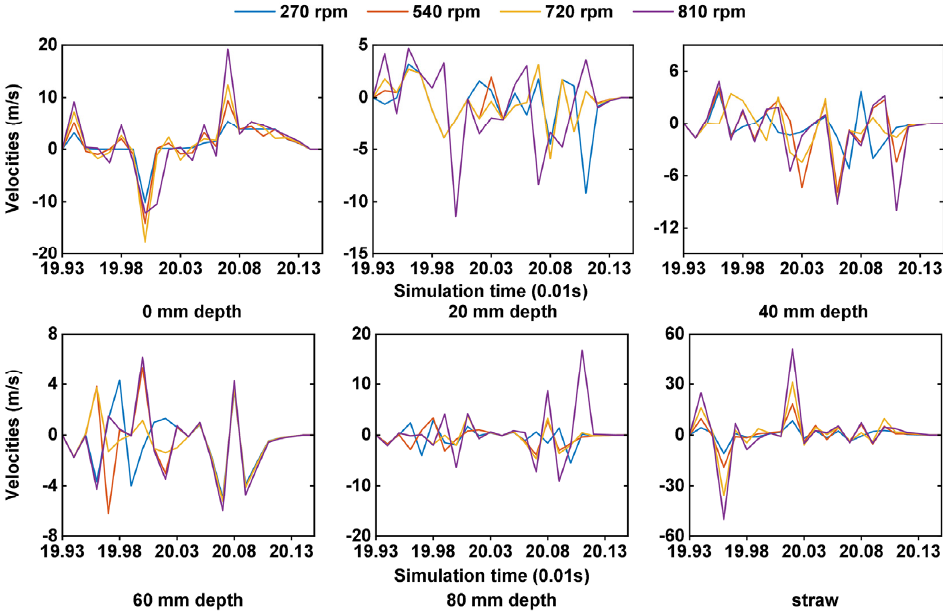
Figure 13. Lateral velocities particles at different depths and surface straws at different rotary speeds with or without air fl ow.